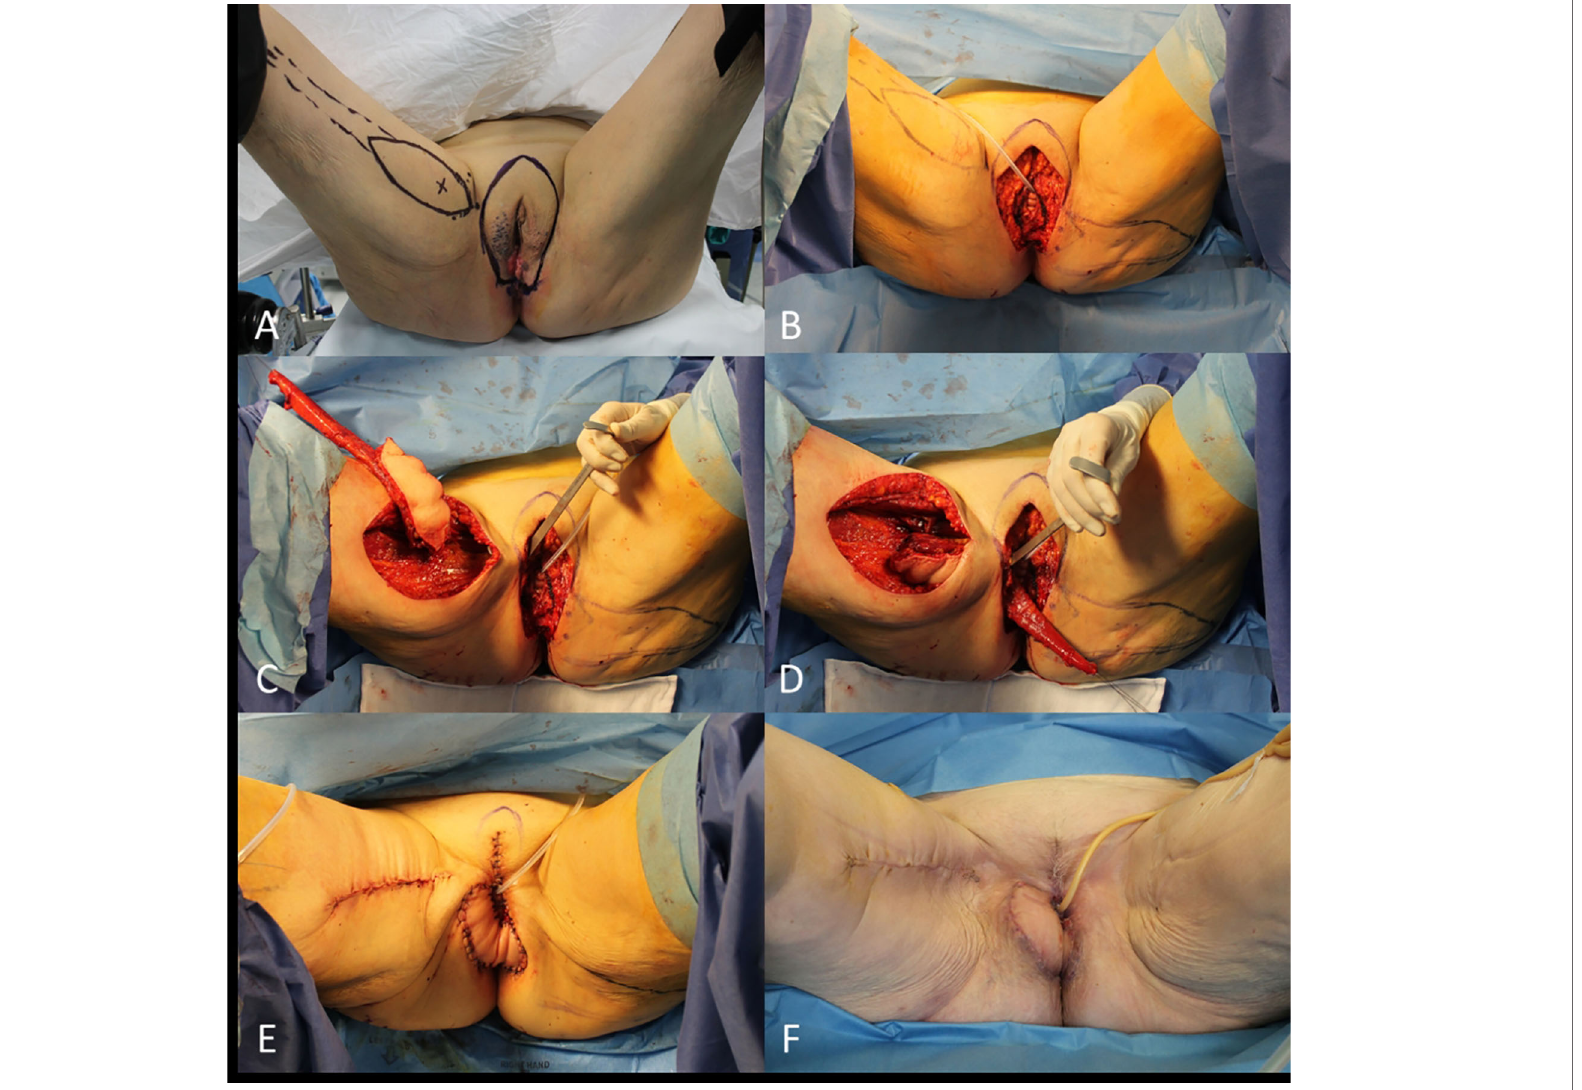
FIGURE 11 | (A) Recurrent cSCC of the vulva and planning of gracilis musculocutaneous fl ap; (B) End of the radical vulvectomy; (C) Flap dissection; (D) Flap transferring; (E) Immediate fi nal result; (F) Final result at 1